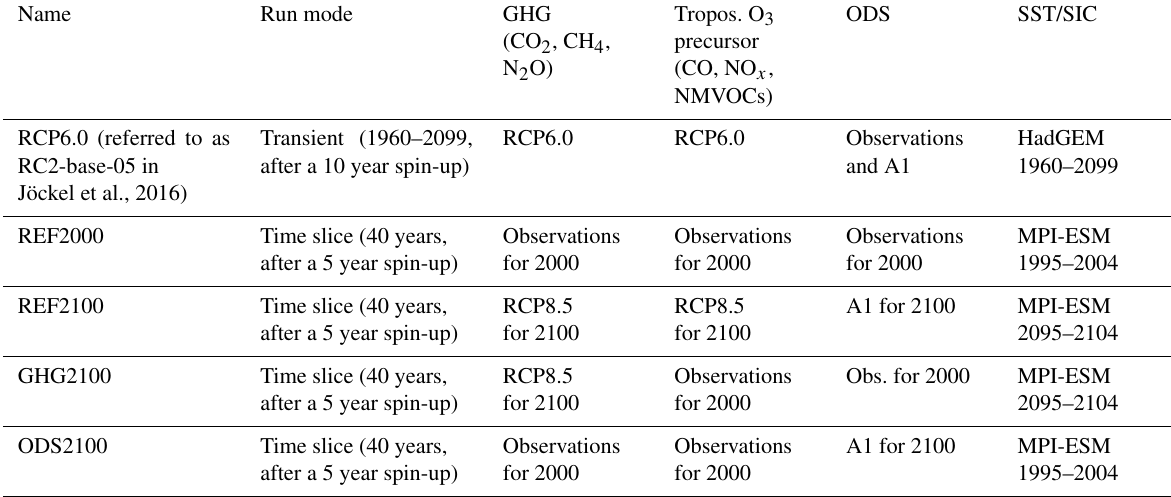
Table 1. EMAC CCM simulations used in this